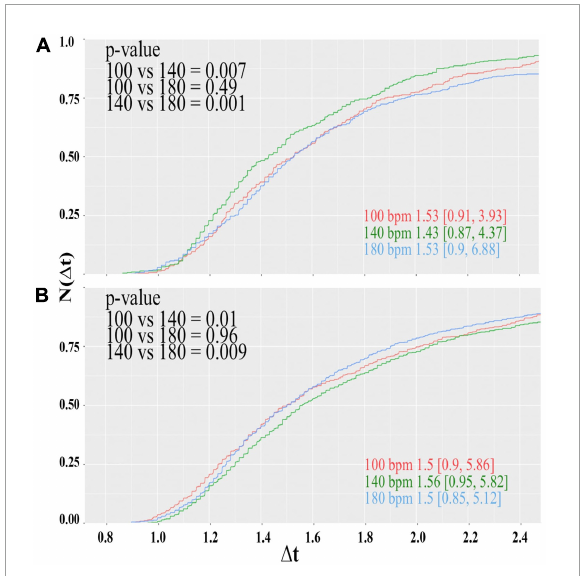
FIGURE4 Cumulative distributions of the reaction times of the color-word matching Stroop task while the participants were under the influence of the acoustic rhythm used in the soccer experiment displayed at 100 (red), 140b (green), and 180 bpm (blue). Panels (A,B) show the results for the male and female subjects, respectively. Inserted numbers indicate the median value and borders of the 95% confidence interval. Furthermore, p -values for the pairwise comparison of the different samples according to the Mann-Whitney-Wilcoxon-rank test are